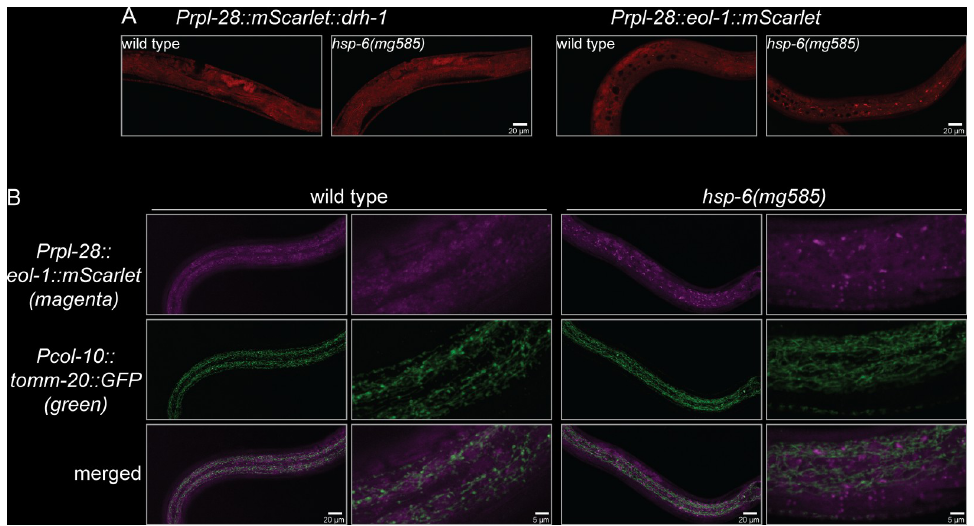
Fig 4. EOL-1 protein forms cytoplasmic foci if mitochondria are dysfunctional. (A) EOL-1 protein, but not DRH-1 protein form puncta in the hsp-6(mg585) mitochondrial mutant but not in wild type. Mitochondrial dysfunction caused by hsp-6(mg585) mutation triggered the formation of EOL-1::mScarlet foci, while mScarlet::DRH-1 remained diffusely localized. (B) EOL-1 foci are not associated with the mitochondria. In the hsp-6(mg585) mutant, the EOL-1::mScarlet foci do not colocalize with mitochondria that were visualized by the mitochondrial outer membrane protein TOMM-20:: GFP.